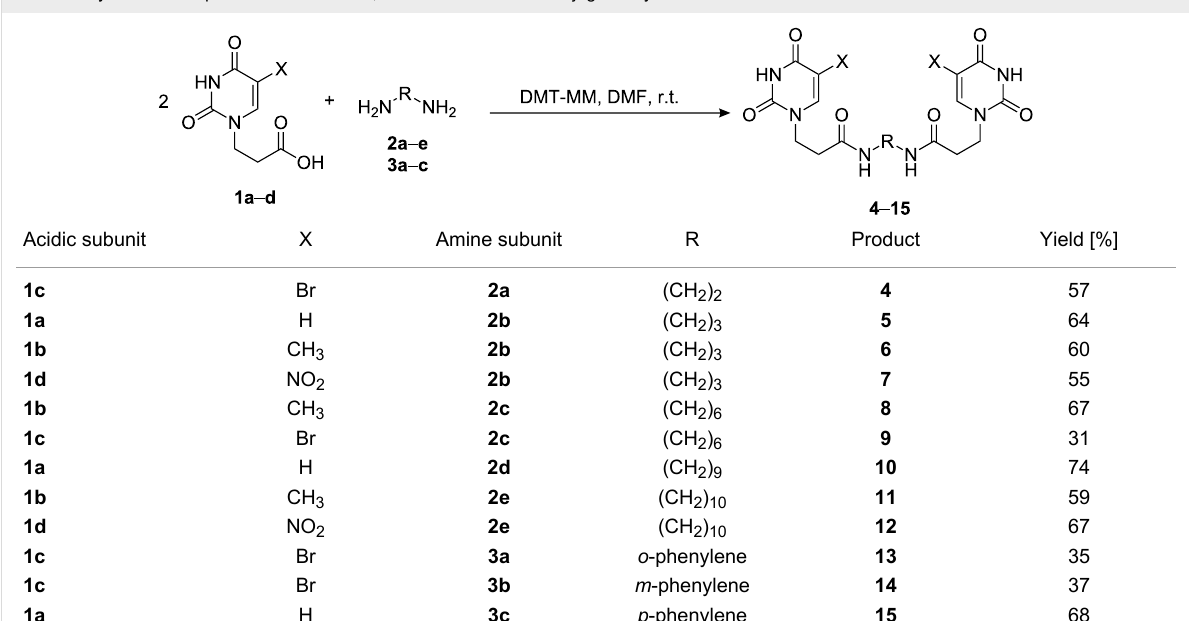
Table 1: Symmetrical aliphatic and aromatic α , ω -nucleobase amide-conjugated systems.